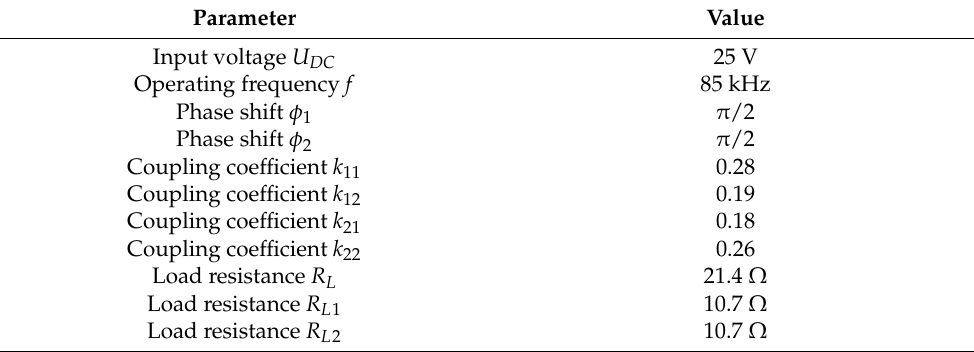
Table 2. Operating